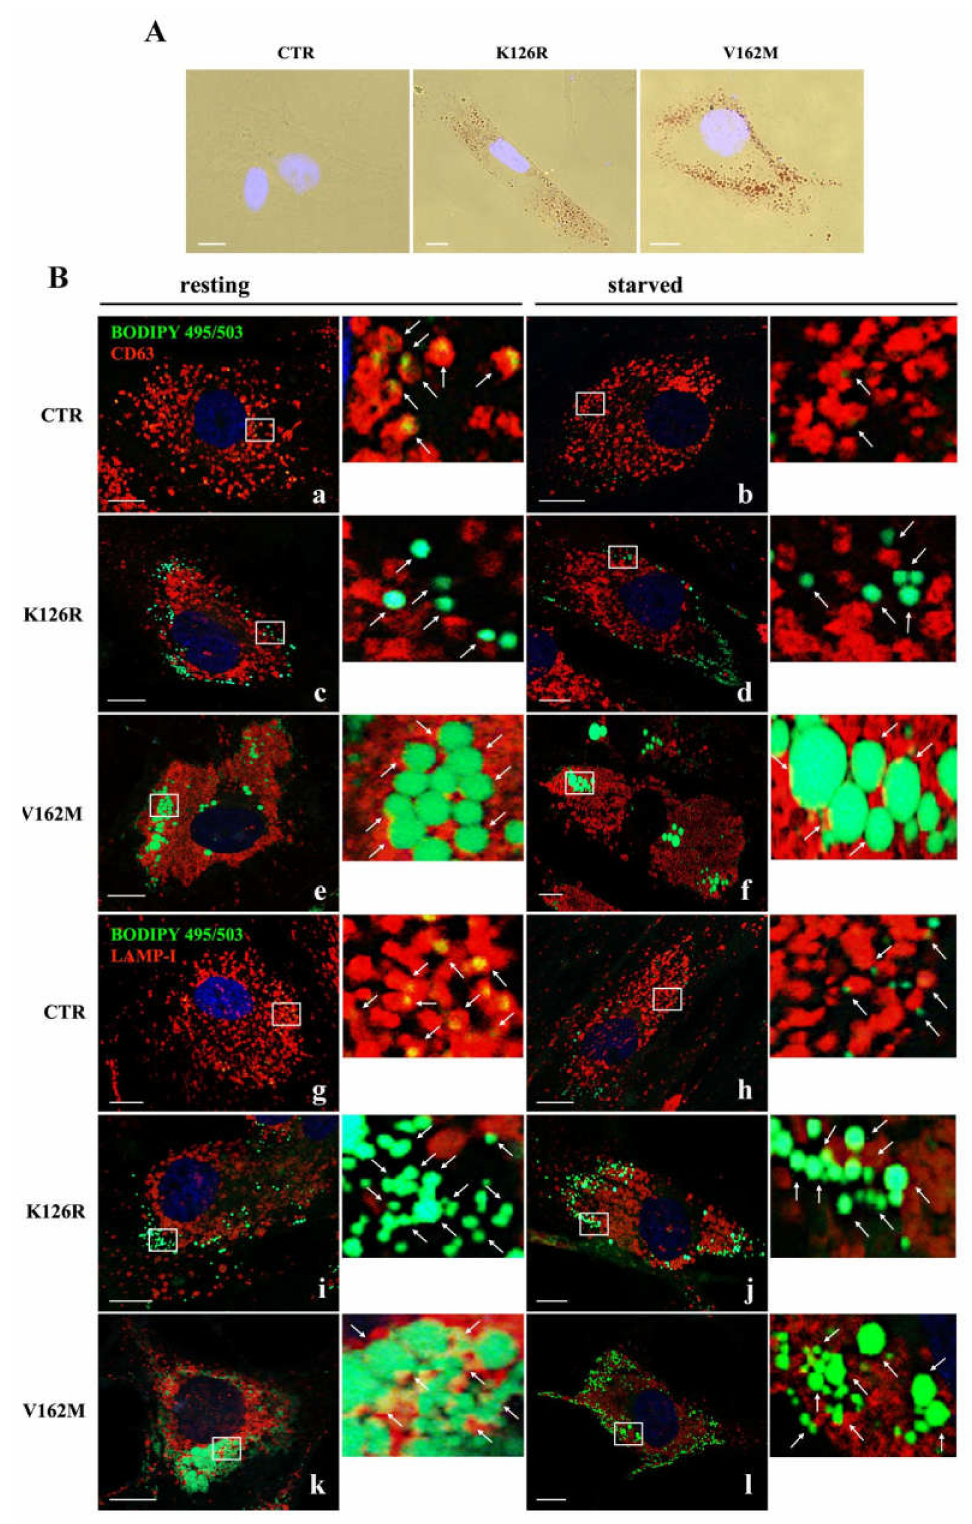
Figure 4. Lipid droplet (LD) accumulation in CMT2B fibroblasts. ( A ) Microscopic observations of the Oil Red-O dye-stained LDs from control (CTR) and CMT2B’s patient’s fibroblasts (K126R and V162M). ( B ) LD interaction with multivesicular bodies (MVBs) and lysosomes was investigated by immunofluorescence analysis using BODIPY 493/503 to label LDs (green) and anti-CD63 (red) and anti-LAMP-I (red) antibodies in cells incubated with full medium (resting condition) and starvation medium (starved condition). White arrows point to LDs. Nuclei were stained with DAPI (blue) White boxes indicated zoomed areas on the right. Scale bar = 10 µ